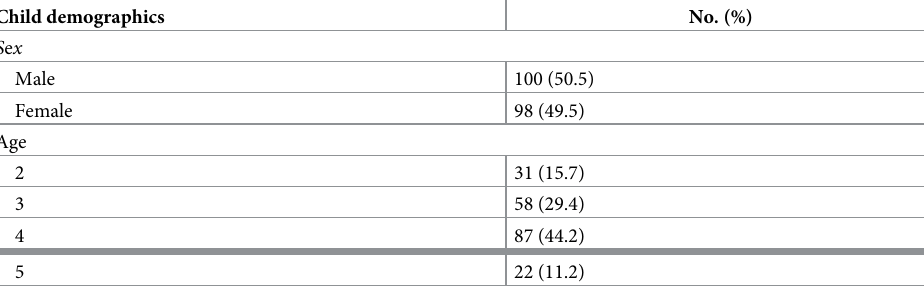
Table 1. Characteristics of participating children.